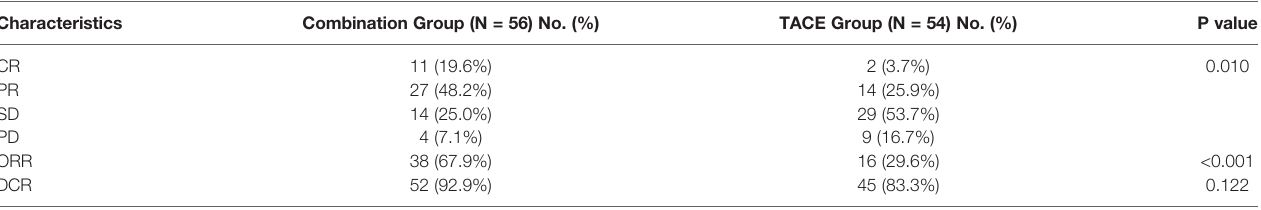
TABLE 2 | Best tumor response according to the mRECIST. Characteristics